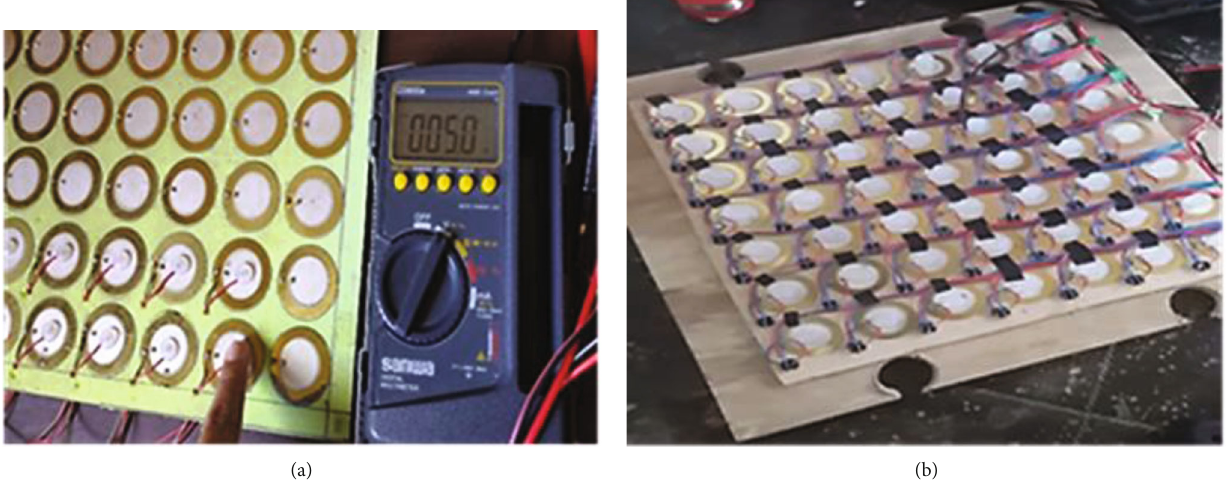
Figure 4: (a) Piezoelectric circuit testing; (b) placement of the